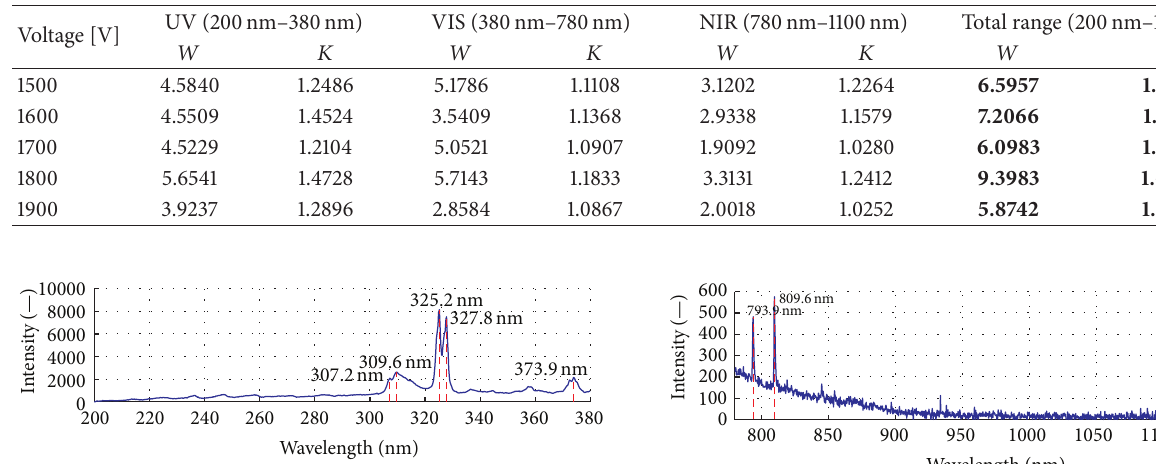
Figure 4: Spectrogram of optical signals emitted by an electric arc by various voltage levels. Table 2: Shape and peak factors calculated over registered spectra at the considered ranges.